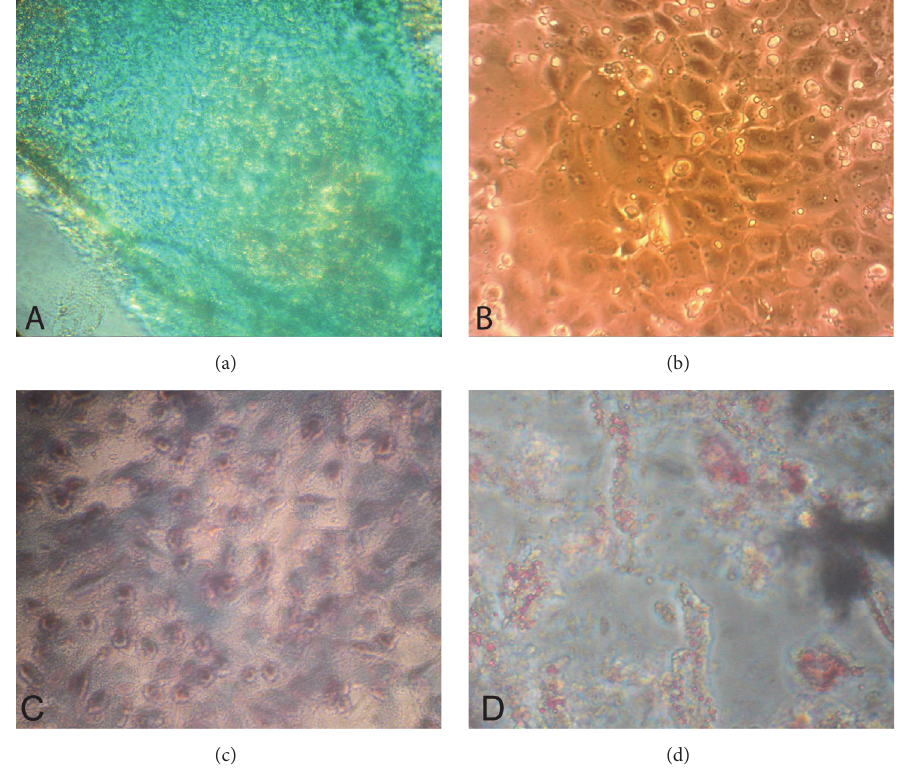
Figure 5: Differentiation of endometrial mesenchymal stromal stem cells (En-MSCs) into (a) chondrocytes stained with Alcian blue shows methachromatic appearance (magnification: × 40). (b) Control cells that remained colorless (magnification: × 100). (c) Alizarin red staining revealed calcification and osteogenic differentiation of En-MSCs in goat (magnification: × 100). (d) Oil Red O staining revealed lipid droplets and adipogenic differentiation of En-MSCs in goat (magnification: ×